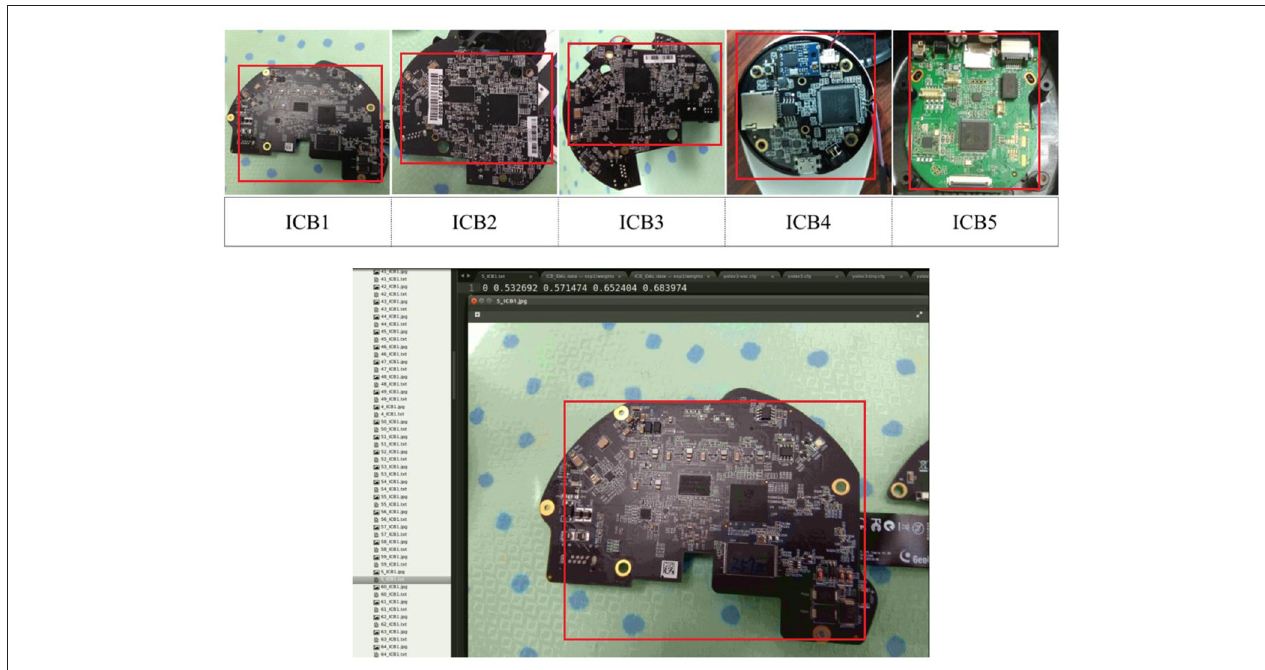
FIGURE 4 | ICB type table and image